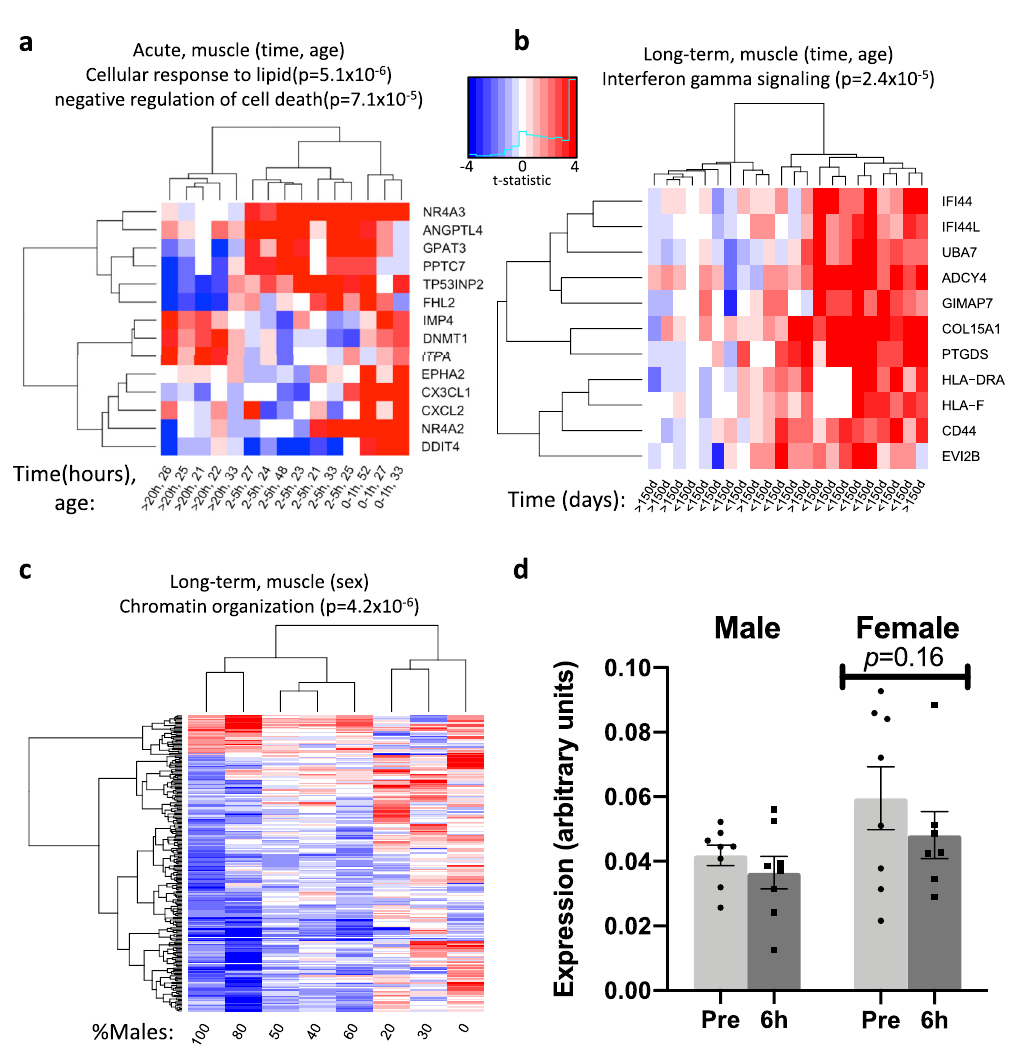
Fig. 6 Covariate-speci fi c transcriptional changes in response to exercise and training in human skeletal muscle. a Heatmap of the 14 genes that were differentially regulated based on time and age after acute exercise. b Heatmap of the 11 genes that were differentially regulated based on time and age after long-term training. c Heatmap of the 247 genes that were associated with sex distribution within a cohort in response to long-term training. Each cell is the average t-statistic of a gene across a set of studies. d Skeletal muscle expression of MTMR3 in males ( n = 8) and females ( n = 8) before and 6 h after an acute endurance exercise bout, analyzed with qRT-PCR in a separate validation cohort. Expression levels are calculated relative to the average of two housekeeping genes ( GAPDH and RPS18 ). Data is presented as mean±standard error of the mean. Source data are provided as a Source Data fi